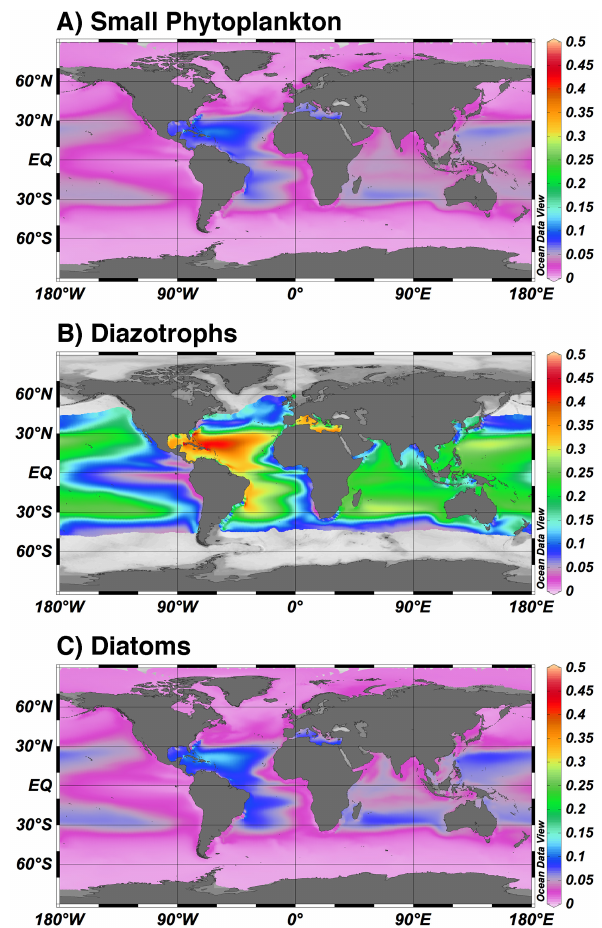
Figure 6. Fraction of total P uptake from DOP integrated over the euphotic zone (upper 100m) for (a) small phytoplankton, (b) dia- zotrophs, and (c) diatoms in the DOM OPT